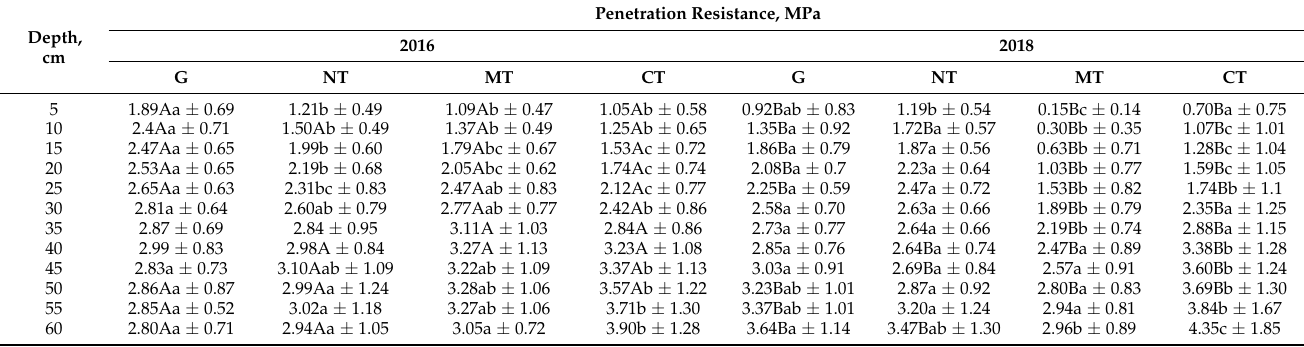
Table 4. Mean soil penetration resistance and standard deviation presented at 5 cm depth interval across different management types (n = 60), where different capital letters following mean values within each depth indicate significant differences between the years within the same system ( t -test, p < 0.05). Different small letters indicate statistical differences ( p < 0.05) between management types at each depth and year according to Tukey post hoc